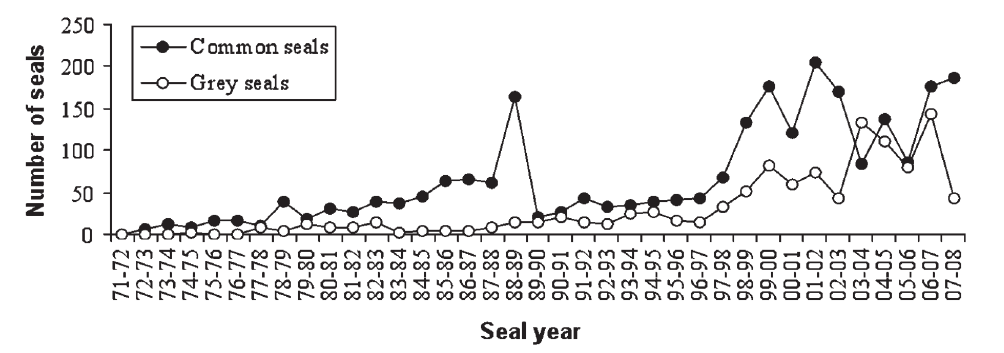
Fig. 1 . Numbers of common seals and grey seals rehabilitated by the SRRC